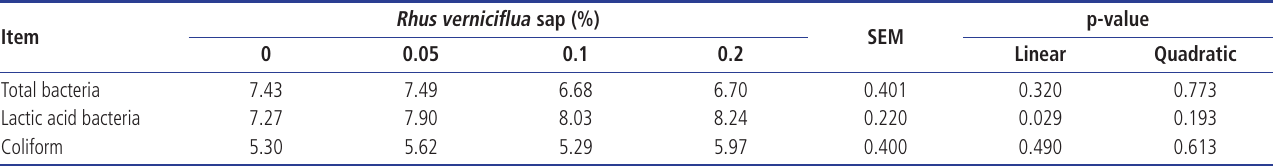
Table 5. Effect of dietary detoxified Rhus verniciflua sap on cecal microflora (log cfu/g of digesta) in laying